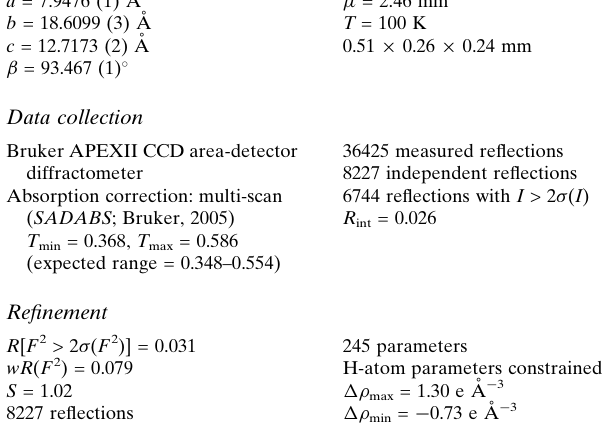
Data collection Bruker APEXII CCD area-detector diffractometer Absorption correction: multi-scan ( SADABS ; Bruker, 2005)